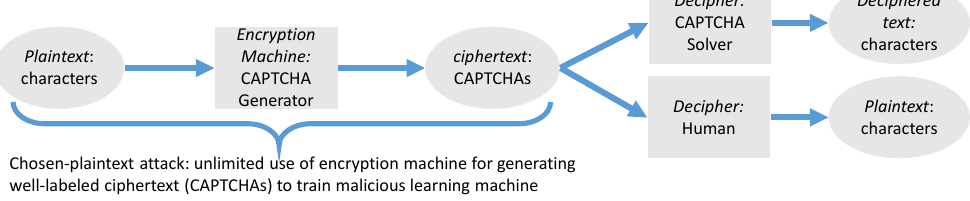
Figure 1. Chosen-plaintext